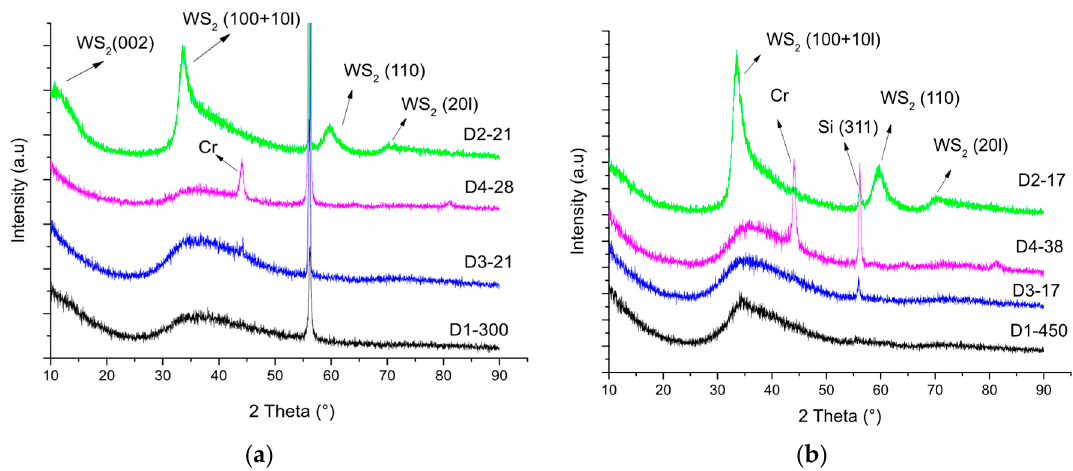
Figure 3. Grazing incidence X-ray diffraction (GIXRD) diffractograms for the coatings deposited by each deposition route: ( a ) lowest C content; ( b ) intermediate C content.